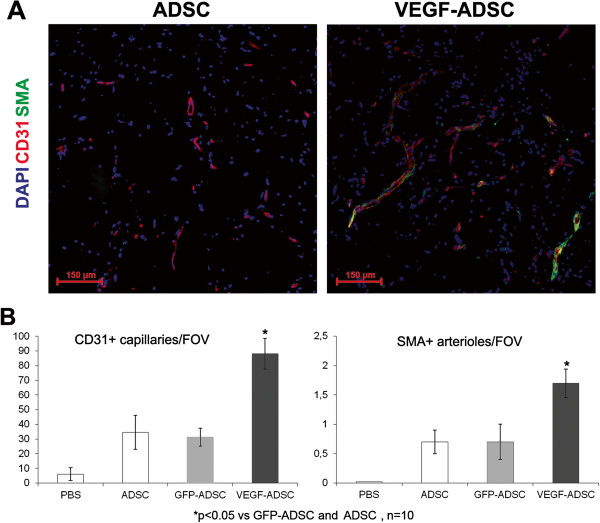
Effect of VEGF-ADSC or ADSC on vascularization of matrigel implants in nude mice. A. Representative images of matrigel sections from “VEGF-ADSC” and “ADSC” groups stained by antibodies against murine CD31 and SMA, 100× magnification. B. Capillaries and arterioles count in matrigel implants.